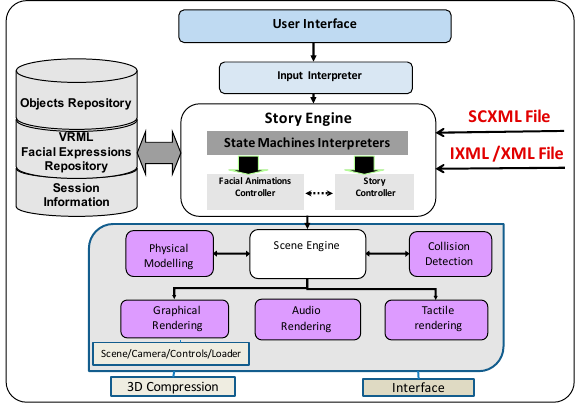
Figure 5. Detailed game engine architecture.